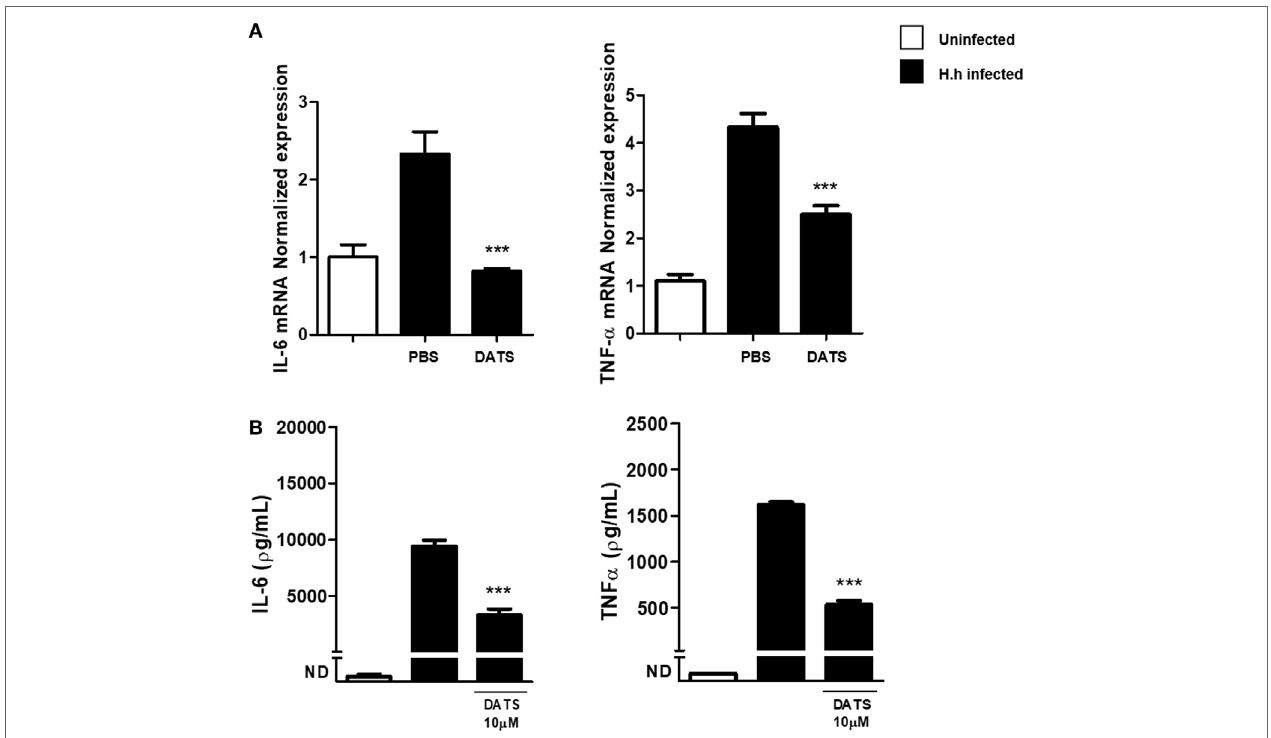
FigUre 5 | DATS reduces pro-inflammatory cytokines production. (a) Relative expression of TNF- α and IL-6 mRNA within the colons of both uninfected mice and Helicobacter hepaticus ( Hh )-infected mice, 6 weeks post-infection, receiving DATS or vehicle (PBS). Expression of cytokines mRNA was determined by real-time quantitative PCR. Data are shown as mean ± SEM ( n = 5 per group) (*** P < 0.001 vs. PBS). (B) Bone marrow-derived macrophages from uninfected mice were stimulated with live Hh (20 MOI). Incubation of cells with DATS (10 µM) significantly reduced IL-6 and TNF α release. Data are shown as mean ± SEM of three pooled independent experiments (*** P < 0.001 vs. Hh